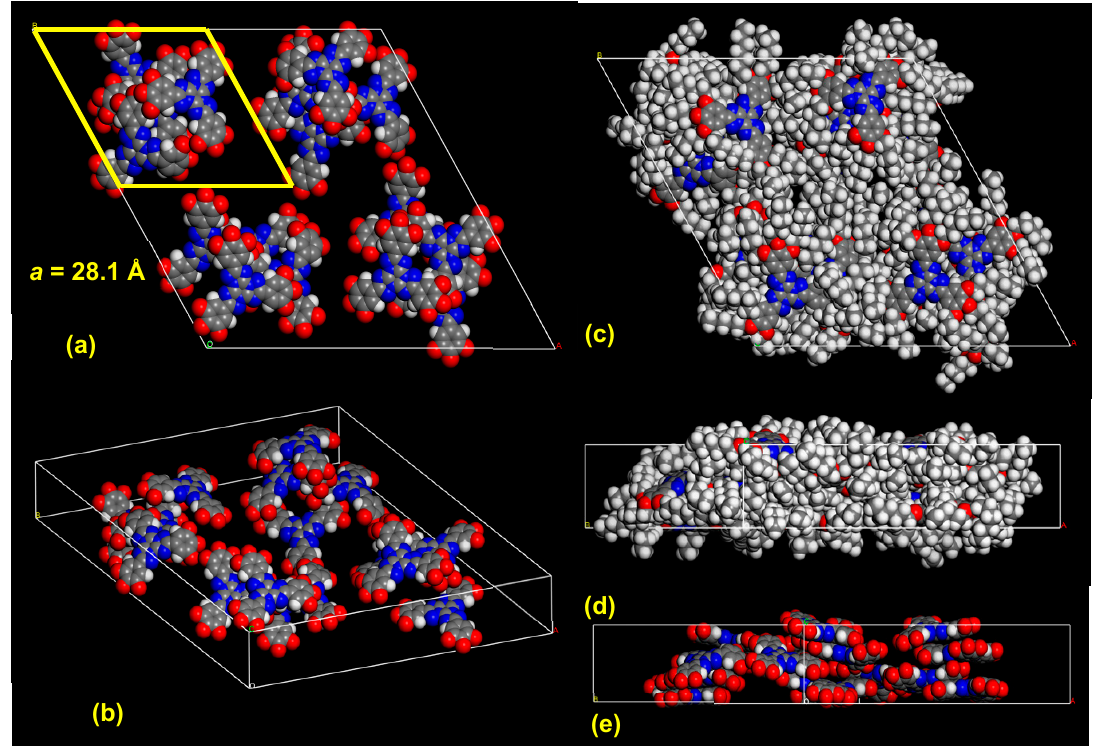
Figure 8. Model of a supercell (2 a × 2 a × 4 c ) of r- 33 . ( a , b ) Top view, where hexyl chains are omitted; ( c , d ) top and side view, including hexyl chains; ( e ) side view, where hexyl chains are omitted.